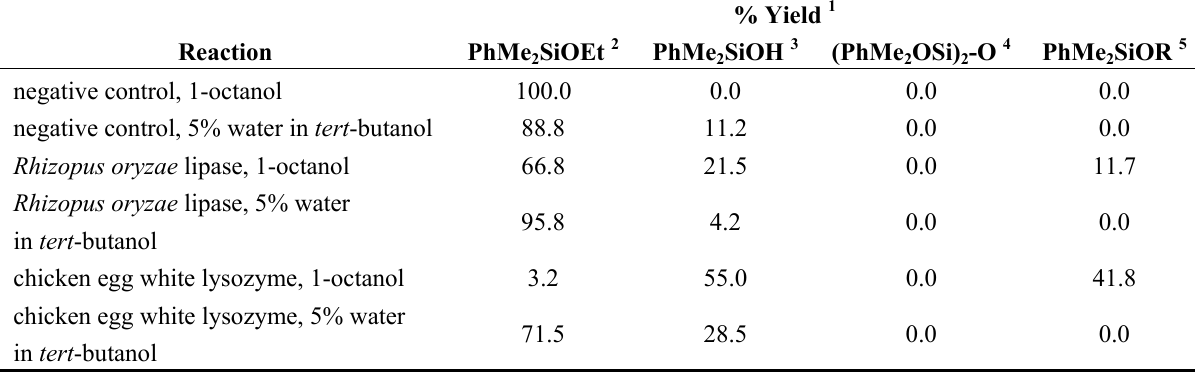
Table 2. Enzyme-catalyzed transetherification reactions between phenyldimethyethoxysilane and 1-octanol or tert -butanol after 24 h at 25